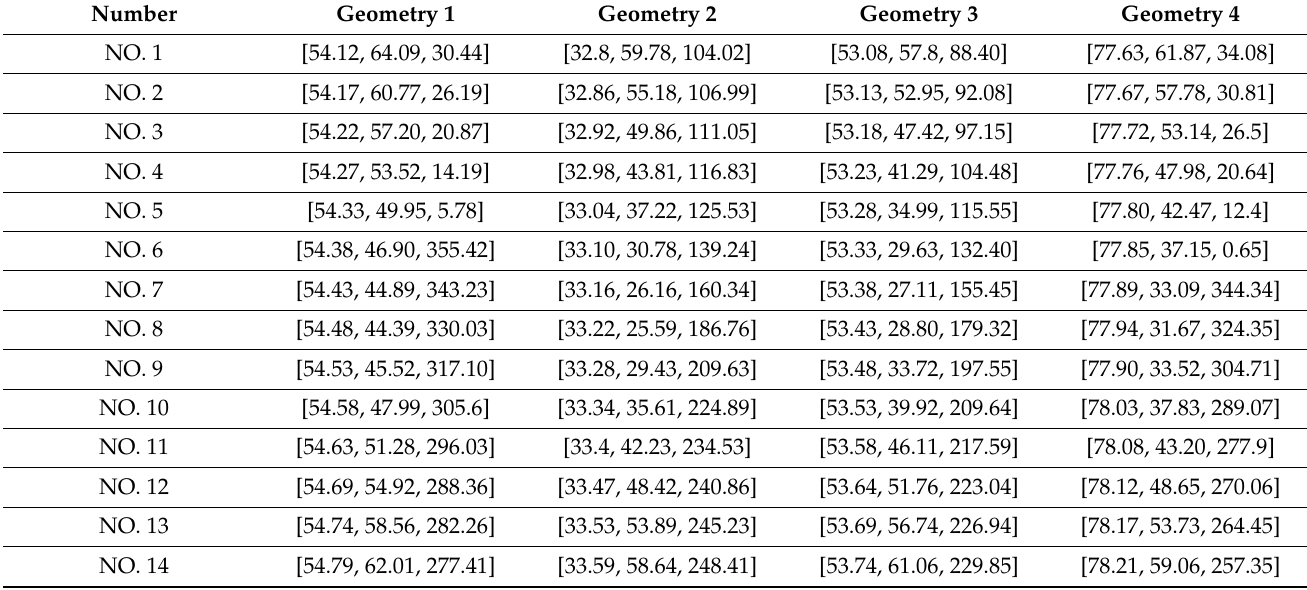
Table A1. Multi-viewing observation geometries for forward simulations (corresponding to Figure 8).